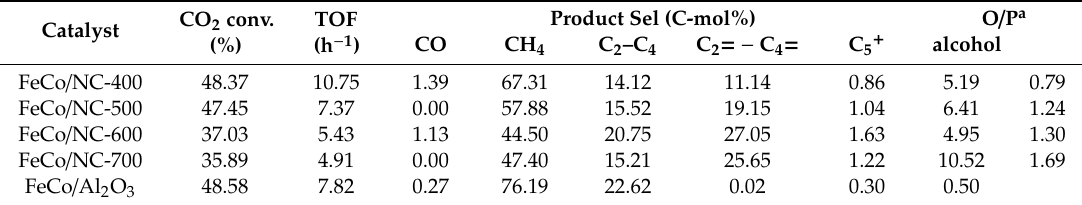
Table 2. CO 2 hydrocarbon conversion and product selectivity over the FeCo / NC-T catalysts.